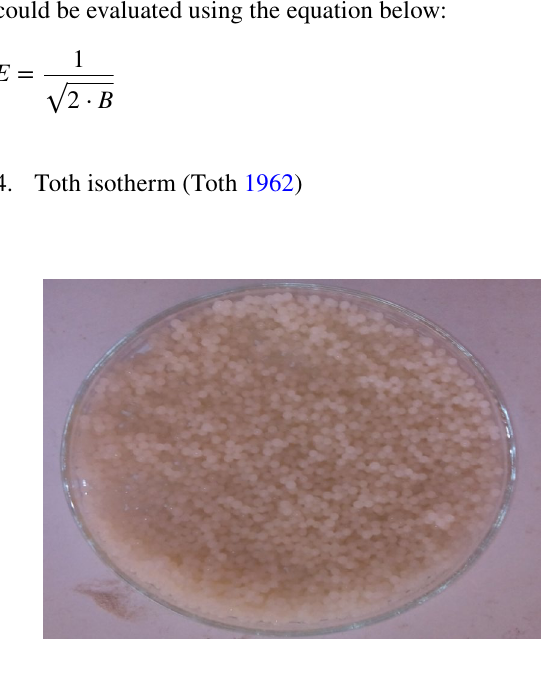
Fig. 1 Activated bentonite/alginate (ABent/A) wet